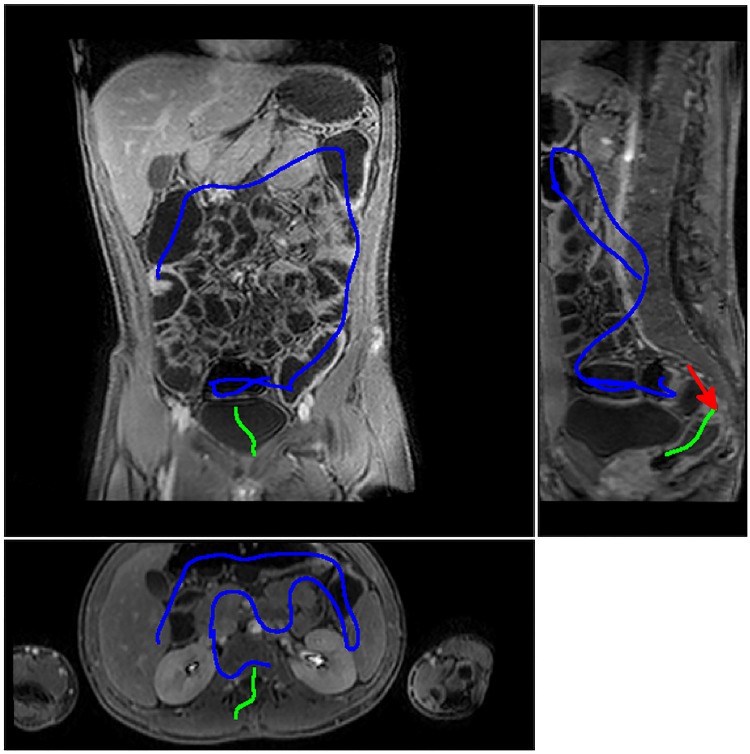
Particle filtering method applied to a patient dataset.The particle filter is first manually initialised in the rectum and tracks the colon to the sigmoid junction (green line) where it is unable to progress due to an area of local colonic collapse (indicated by the red arrow). The algorithm is manually reinitialised at the other side of the collapse and is able to track the colon through to the caecum (blue line). The figure shows both of these three dimensional lines projected onto a single coronal (top left), sagittal (top right) and axial (bottom) plane, and therefore travels in, and out of plane.